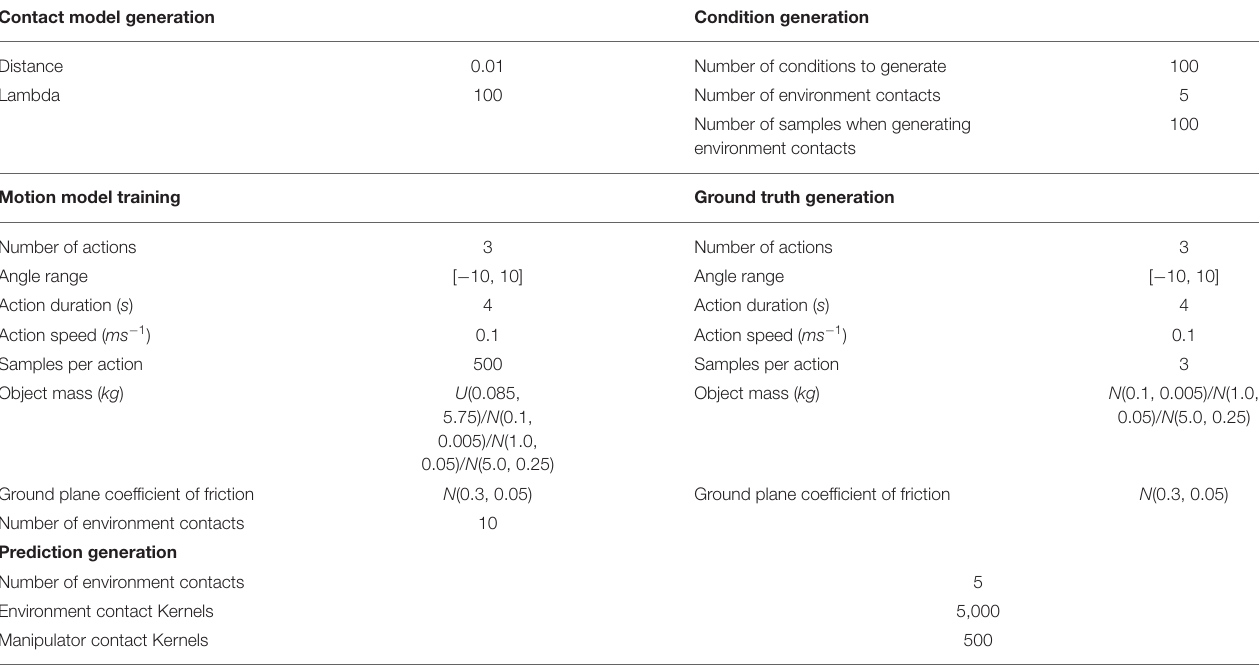
TABLE 4 | Experimental parameters for evaluating the prediction accuracy on novel objects (section 8.3) under various mass biasing